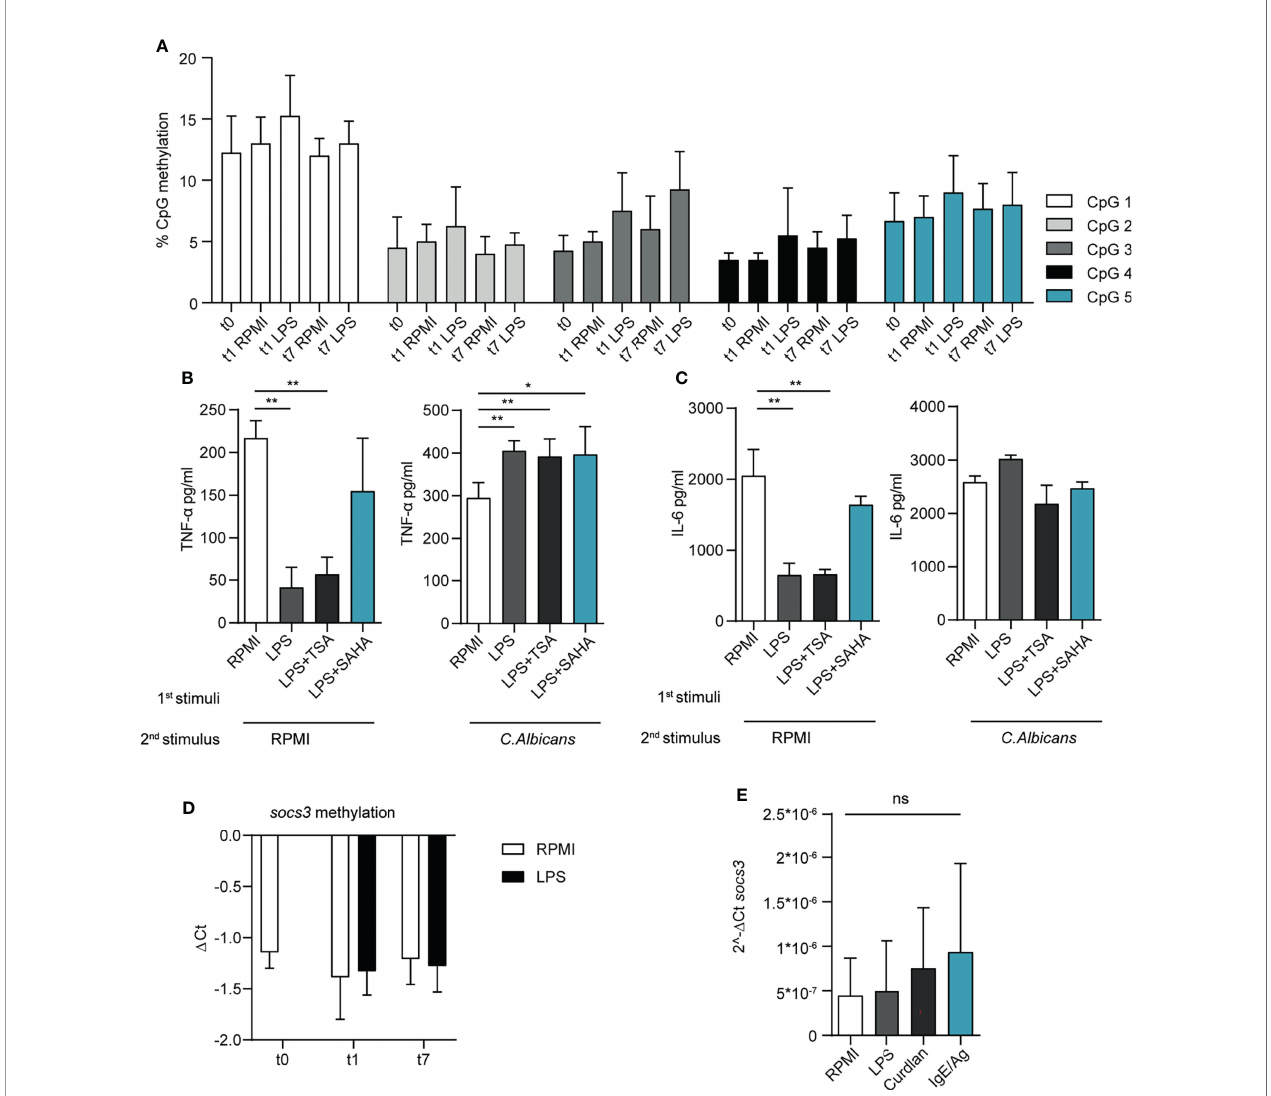
FIGURE 5 | LPS priming affects the epigenetic landscape in MCs. (A) CpG methylation at TNF- a promoter region. A total of fi ve CpG sites were analysed in the selected region, their level of methylation was determined by pyrosequencing. Mean + SD of n=3-5 independent experiments are reported. BMMC were primed with LPS (1 m g/ml) in presence of HDAC inhibitors (SAHA 1nM; TSA 10nM), then washed, re-stimulated and analysed for TNF- a (B) and IL-6 (C) secretion upon second stimulation with LPS or C. albicans . Mean + SD of n=3 independent experiments are reported. (D) SOCS3 promoter CpG methylation was determined by